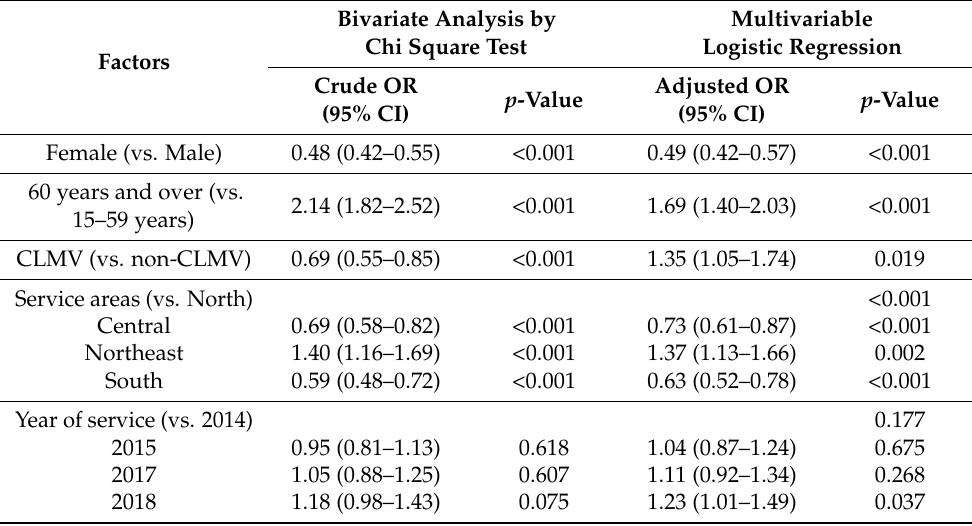
Table 4. Factors associated with NCD IP care among expatriate patients in Thailand, 2014–2018. Factors